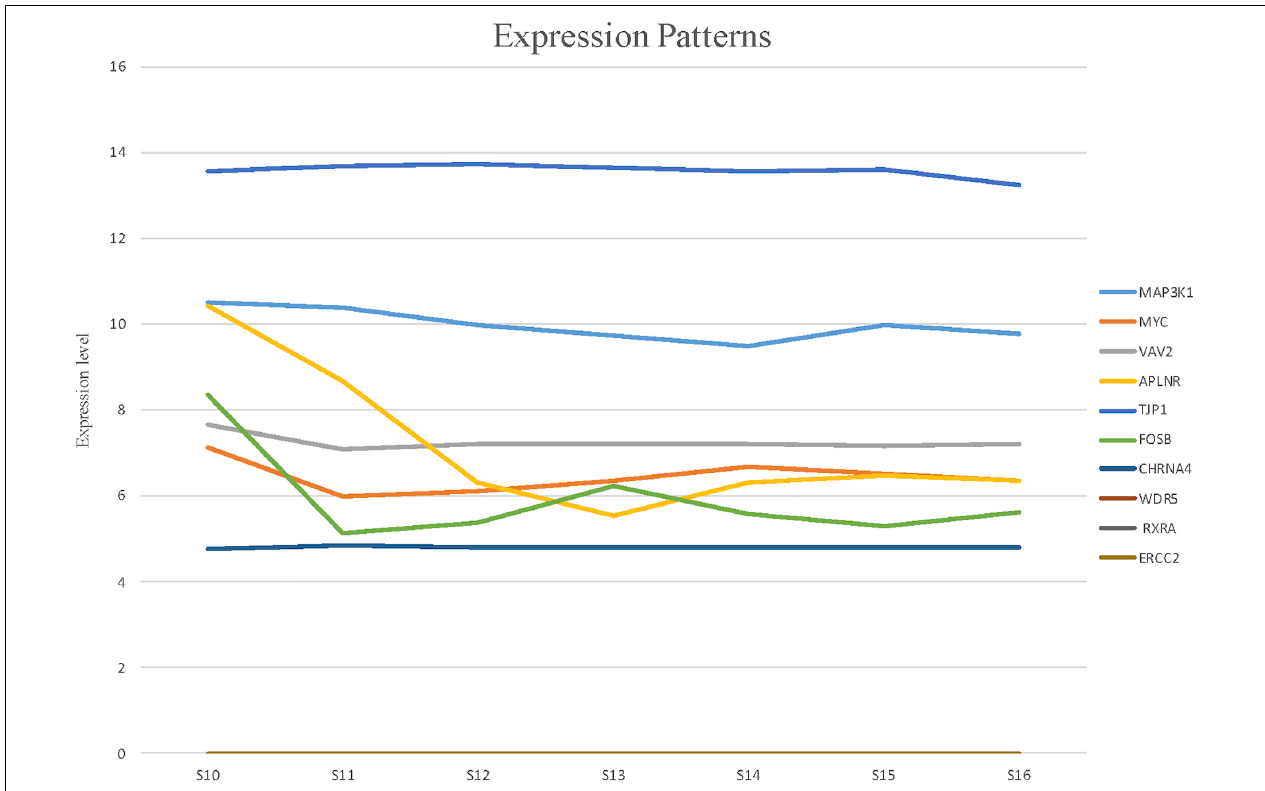
FIGURE 6 | The expression patterns of candidate genes in human embryonic heart at different stages of S10 to S16 were analyzed by microarray. Among these candidate genes, the expression levels of CHRNA4 were significantly higher than those of other genes.